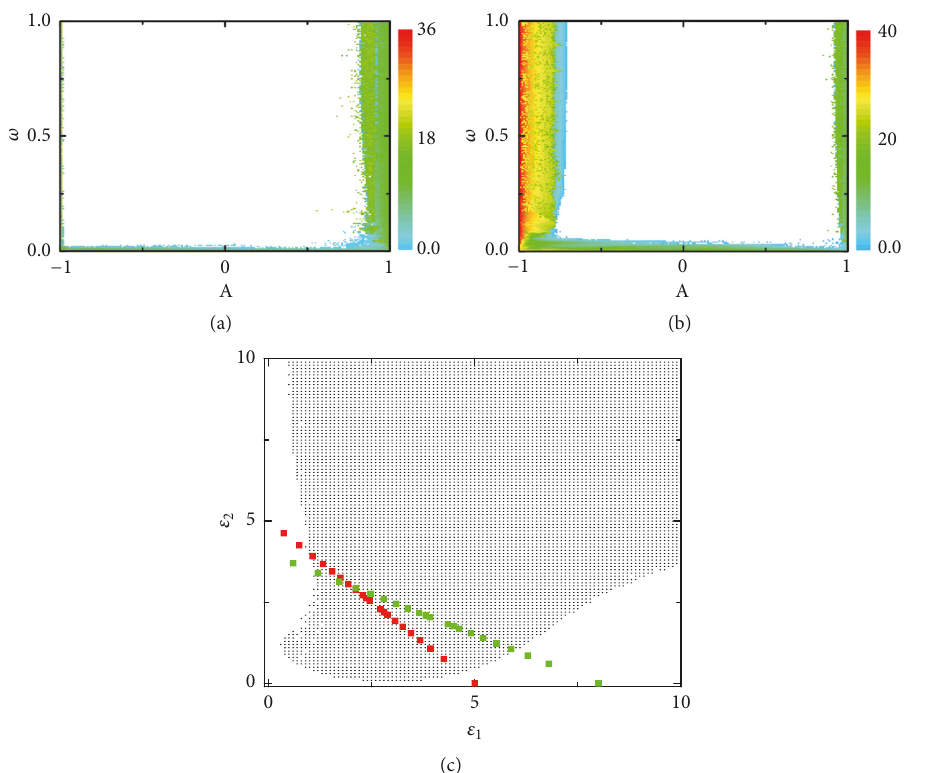
Figure 4: The contour plot of the synchronization error Δ in the plane of 𝐴 and 𝜔 in (a) for 𝜀 1 = 5 and 𝜀 2 = 5 and in (b) for 𝜀 1 = 8 and 𝜀 2 = 4 . (c) The phase diagram showing the CS region in the plane of 𝜀 1 and 𝜀 2 for the time-independent duplex network with two layers represented by 𝐿 1 and 𝐿 2 . The dot line denotes the effective 𝜀 1,𝑒 and 𝜀 2,𝑒 acquired by the fast-switching approximation. H 1 ( x 𝑗 − x 𝑖 ) = [𝑦 𝑗 − 𝑦 𝑖 , 0,0] and H ( x − x ) = [𝑧 − 𝑧 ,0, 0] 2 𝑗 𝑖 𝑗 𝑖